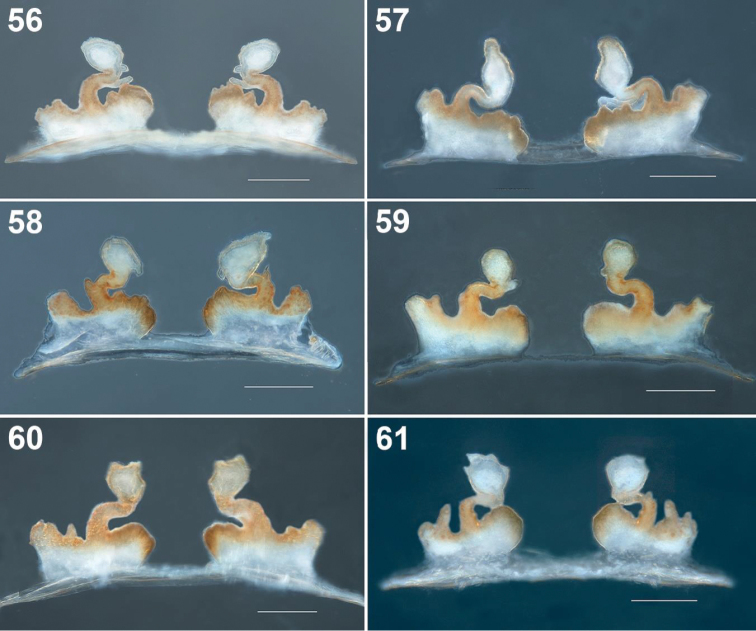
Loxosceles
tenochtitlan sp. nov. Variation of the seminal receptacles of the females, dorsal views 56 Street Cruz Verde #132, Tlalpan, Mexico City (type locality) (female paratype) 57 Los Reyes Copilco, Fracc. Areada Dpto. 102-A, Coyoacán, Mexico City 58 Street Juárez #23, San Mateo Ixtacalco, Municipality Cuautitlán Izcalli, Estado de Mexico 59 Street Reforma #5, Santiago Tlacochcalco, Municipality of Tepeyanco, Tlaxcala 60, 61 Street Juárez Norte #214, Huamantla, Municipality of Huamantla, Tlaxcala, Mexico.